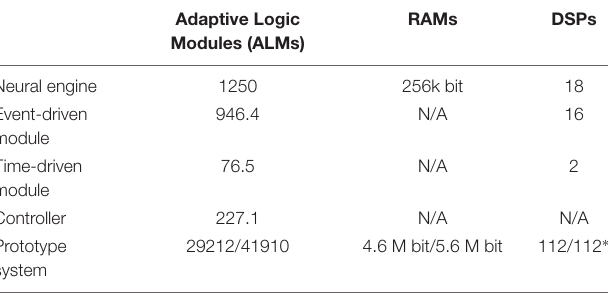
TABLE 3 | Device utilization Altera cyclone 5CSXFC6D6F31C6.